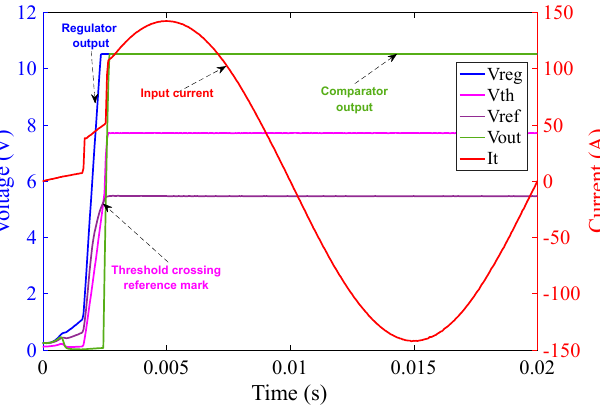
Figure 19. 1 Ω burden circuit operation at 100 A(rms) input current over the duration of 3 ms.